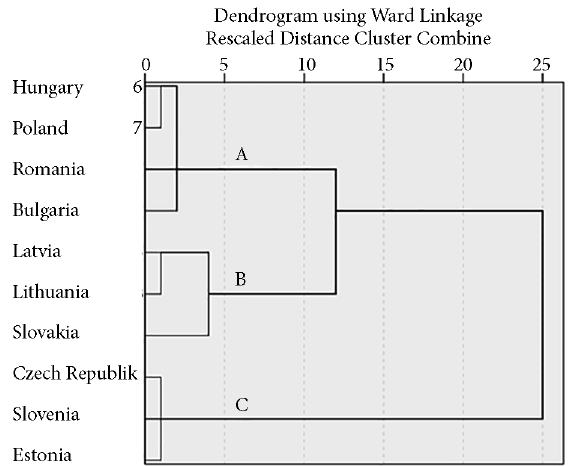
Figure 1. Cluster generation dendrogram by Ward Linkage (source: authors’ own design) Table 3. Average values of variables for clusters (source: authors ‘own computations) Clus- GDP BRT CHR ter